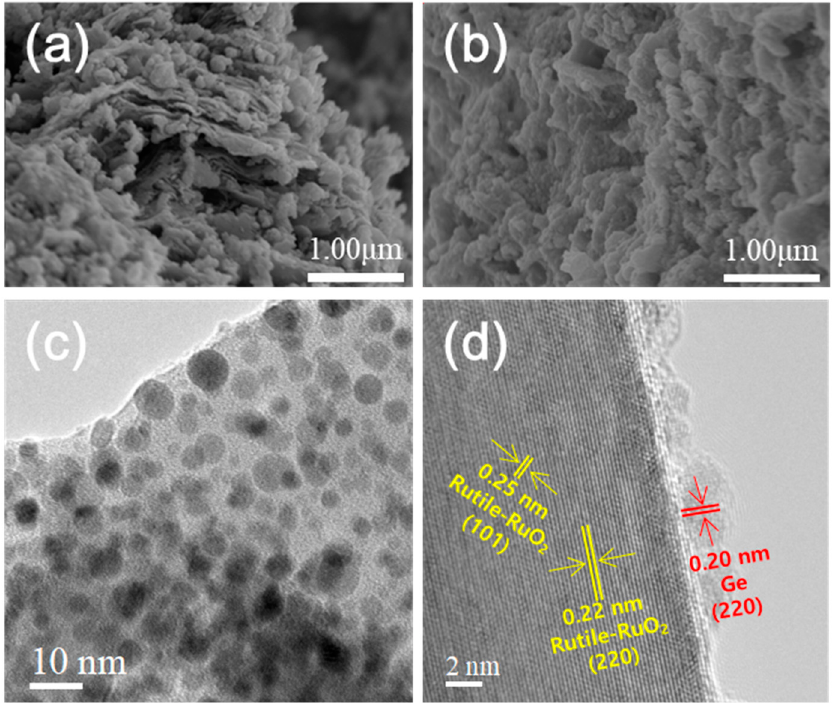
Figure 4. SEM images of ( a ) Ge/RuO 2 and ( b ) Ge/RuO 2 nanocomposite. TEM images of Ge/RuO 2 nanocomposite in ( c ) low magnification and ( d ) high magnification.